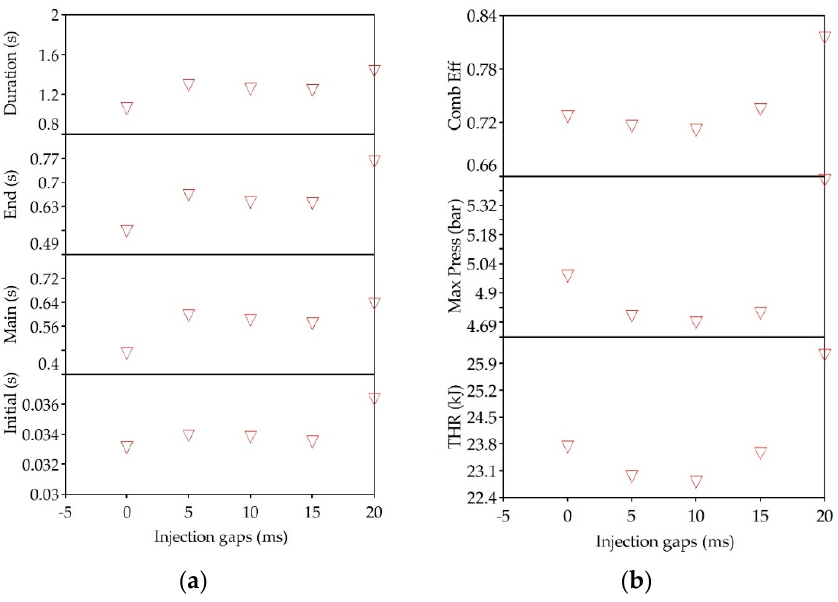
Figure 9. Combustion performance of diesel/CNG for various injection gaps for 60/40 Diesel/CNG. ( a ) Combustion phasing; ( b ) Combustion performance.